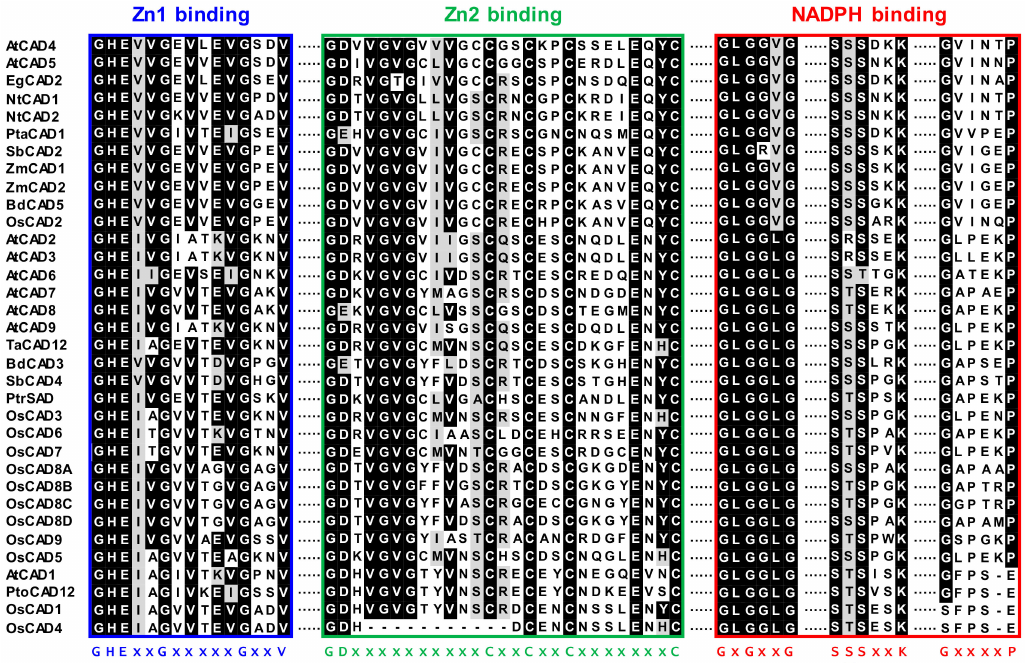
Figure 2. The conserved Zn binding motifs and NADPH binding consensus in plant CADs. Multiple alignment of the amino acid sequences in the OsCADs and other plant CADs was performed and the conserved motifs are presented. The consensus sequences are indicated below the alignments (x indicates any amino acid). AtCAD1-9 from A. thaliana , EgCAD2 from E. gunnii , NtCAD1 and 2 from N. tabacum , PtaCAD1 from P. taeda , SbCAD2 and 4 from S. bicolor , ZmCAD1 and 2 from Z. mays, BdCAD3 and 5 from B. distachyon , TaCAD12 from T. aestivum , PtoCAD12 from P. tomentosa , and PtrSAD from P. tremuloides